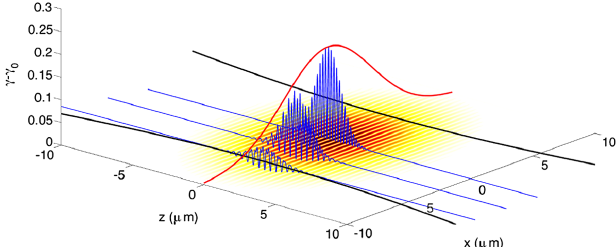
FIG. 5. Illustration showing the electron γ factor as it prop- agates through a focussed pulse with varying impact parameter. In this example the electron had an initial γ 0 ¼ 5 and was inserted 0 , x w 0 = 2 and into the laser with impact parameters of x i ¼ i ¼ x w 0 , which correspond to the three blue lines in the plot i ¼ (back to front, respectively). The laser pulse had a peak a 0 ¼ 2 , λ ¼ 0 . 8 μ m and was focussed to a waist of w 5 μ m 0 ¼ ( θ 0 ¼ 0 . 05 ). The duration was reduced to 20 fs to aid clarity of illustration. The yellow-black shading illustrates the intensity profile at t ¼ 0 . The curved black lines in the x − z plane show the beam waist w . The red curve in the x − γ plane shows the transverse profile function, exp ð − r 2 =w 2 Þ , evaluated at y ¼ z ¼ 0